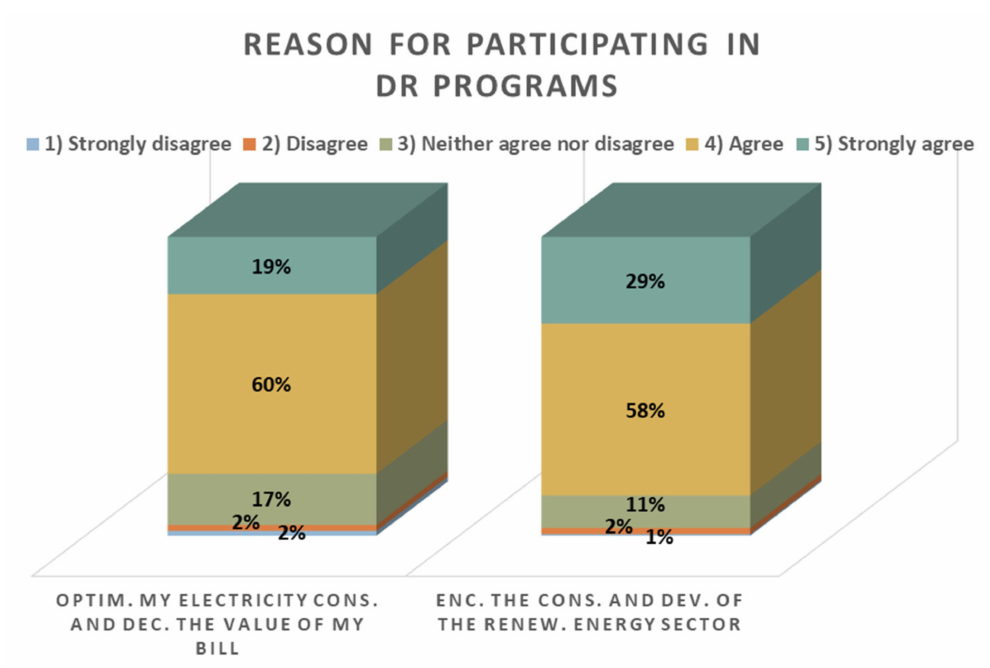
Figure 4. Participation of consumers in DR programs in order to reduce electricity bills and the development of the renewable sector. Source: Authors’ own research.